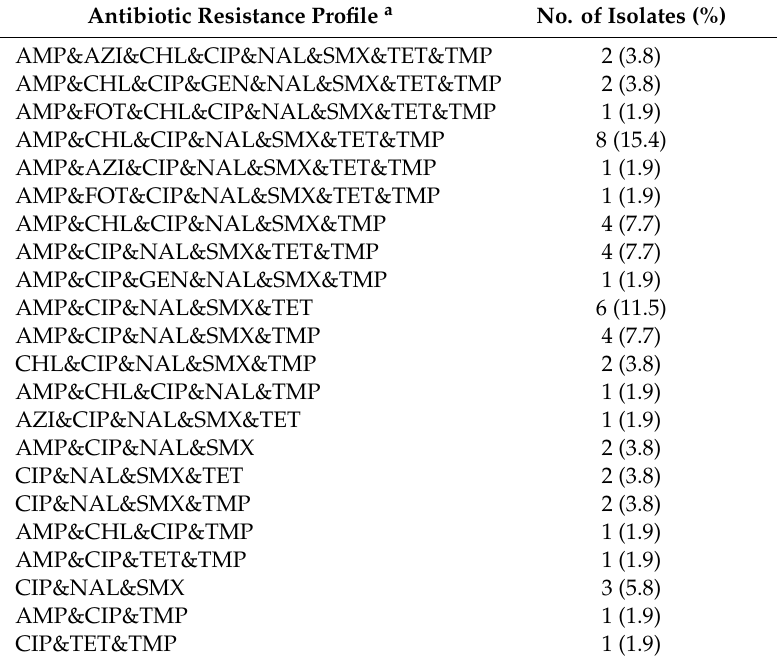
Table 5. Number and percentage of ciprofloxacin-resistant E. coli isolates resistant to the antibiotics tested in the EUVSEC panel.